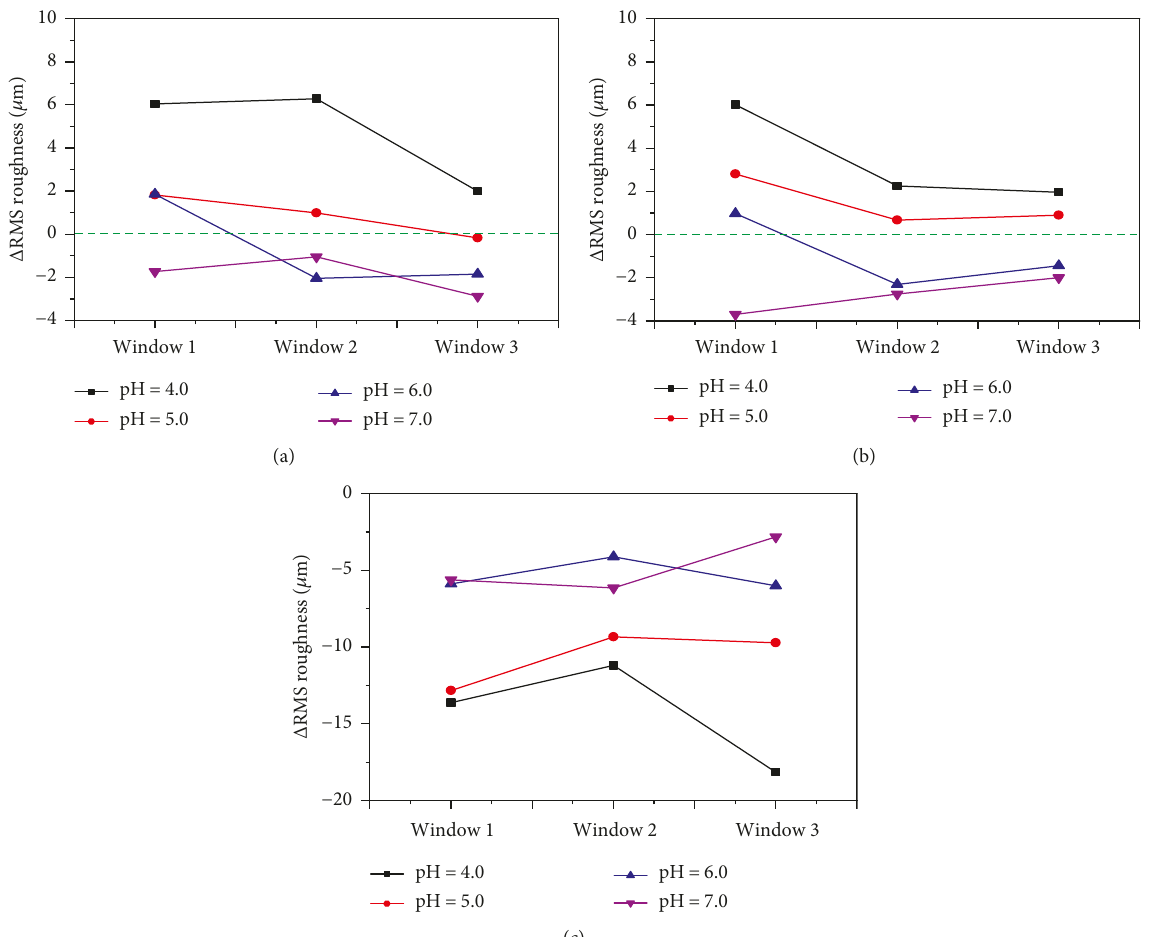
Figure 9: RMS roughness change after core fl ooding experiments. x -axis is the measurement window with fl uid fl ow direction from left (upstream) to right (downstream). (a) Longmaxi shale, (b) Green River shale, and (c) Marcellus shale. Δ RMS larger than 0 means roughness increase and potentially fracture aperture gaping while Δ RMS smaller than 0 indicates a roughness decrease and a fracture aperture